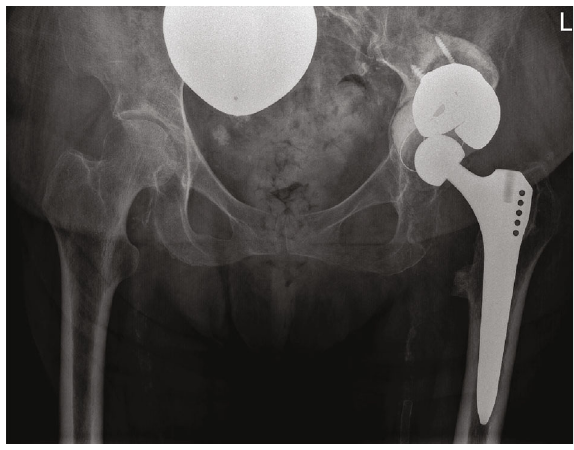
Figure 4: Postoperative pelvic overview with acetabular defect fi lling using three tantalum augments in a “ football ” con fi guration and reconstruction of the hip center of